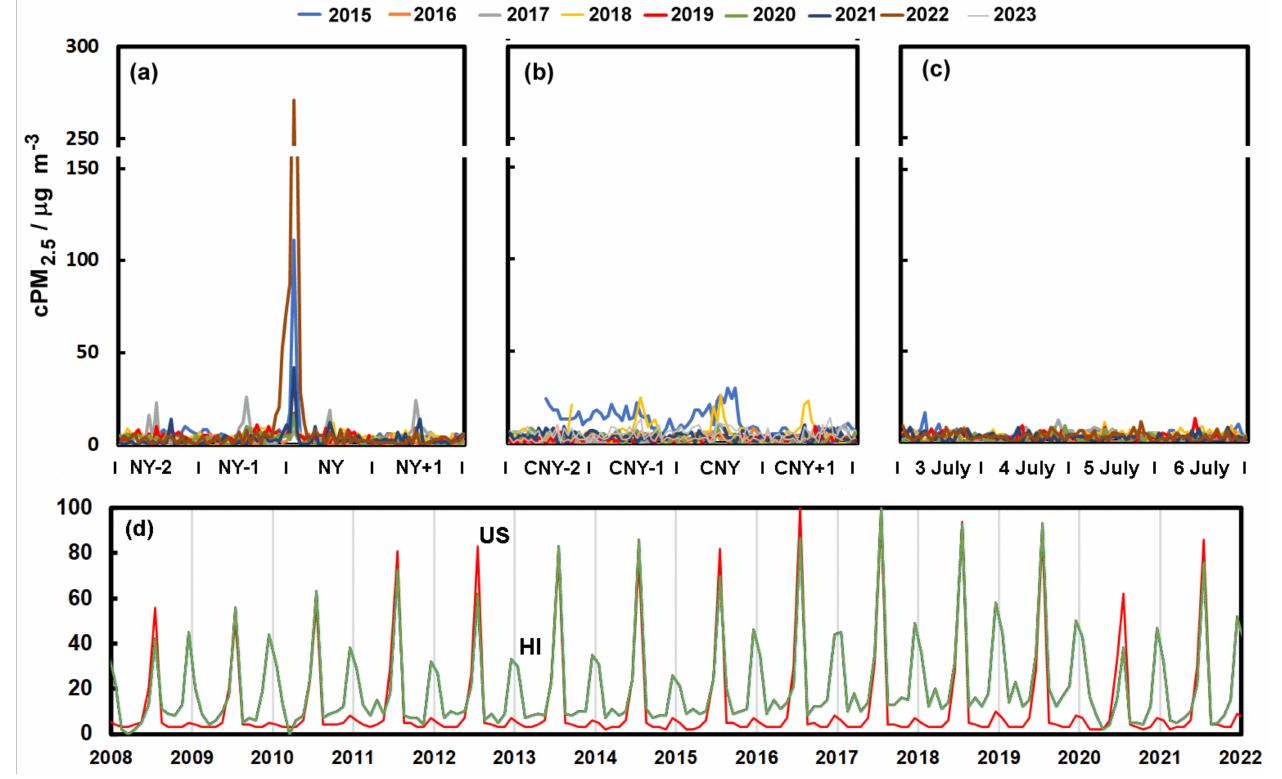
Figure 1. Hourly PM 2.5 concentrations in Honolulu before and after (across four-day windows): ( a ) New Year 2015–2022, ( b ) Spring Festival (Chinese New Year) 2015/2023, and ( c ) Independence Day 2015/2022. ( d ) The normalised search volume for “fireworks” in the U.S. and Hawaii (HI) 2004/2022 as recorded in Google Trends. Abbreviations NY − 2 day before New Year’s Eve, NY − 1 New Year’s Eve, NY New Year’s Day, and NY+1 Day after New Year’s Day. Chinese New Year follows this pattern, but Independence Day has the calendar dates. Note a rescaled version of Figure 1a–c appears as Supplementary Figure S1.